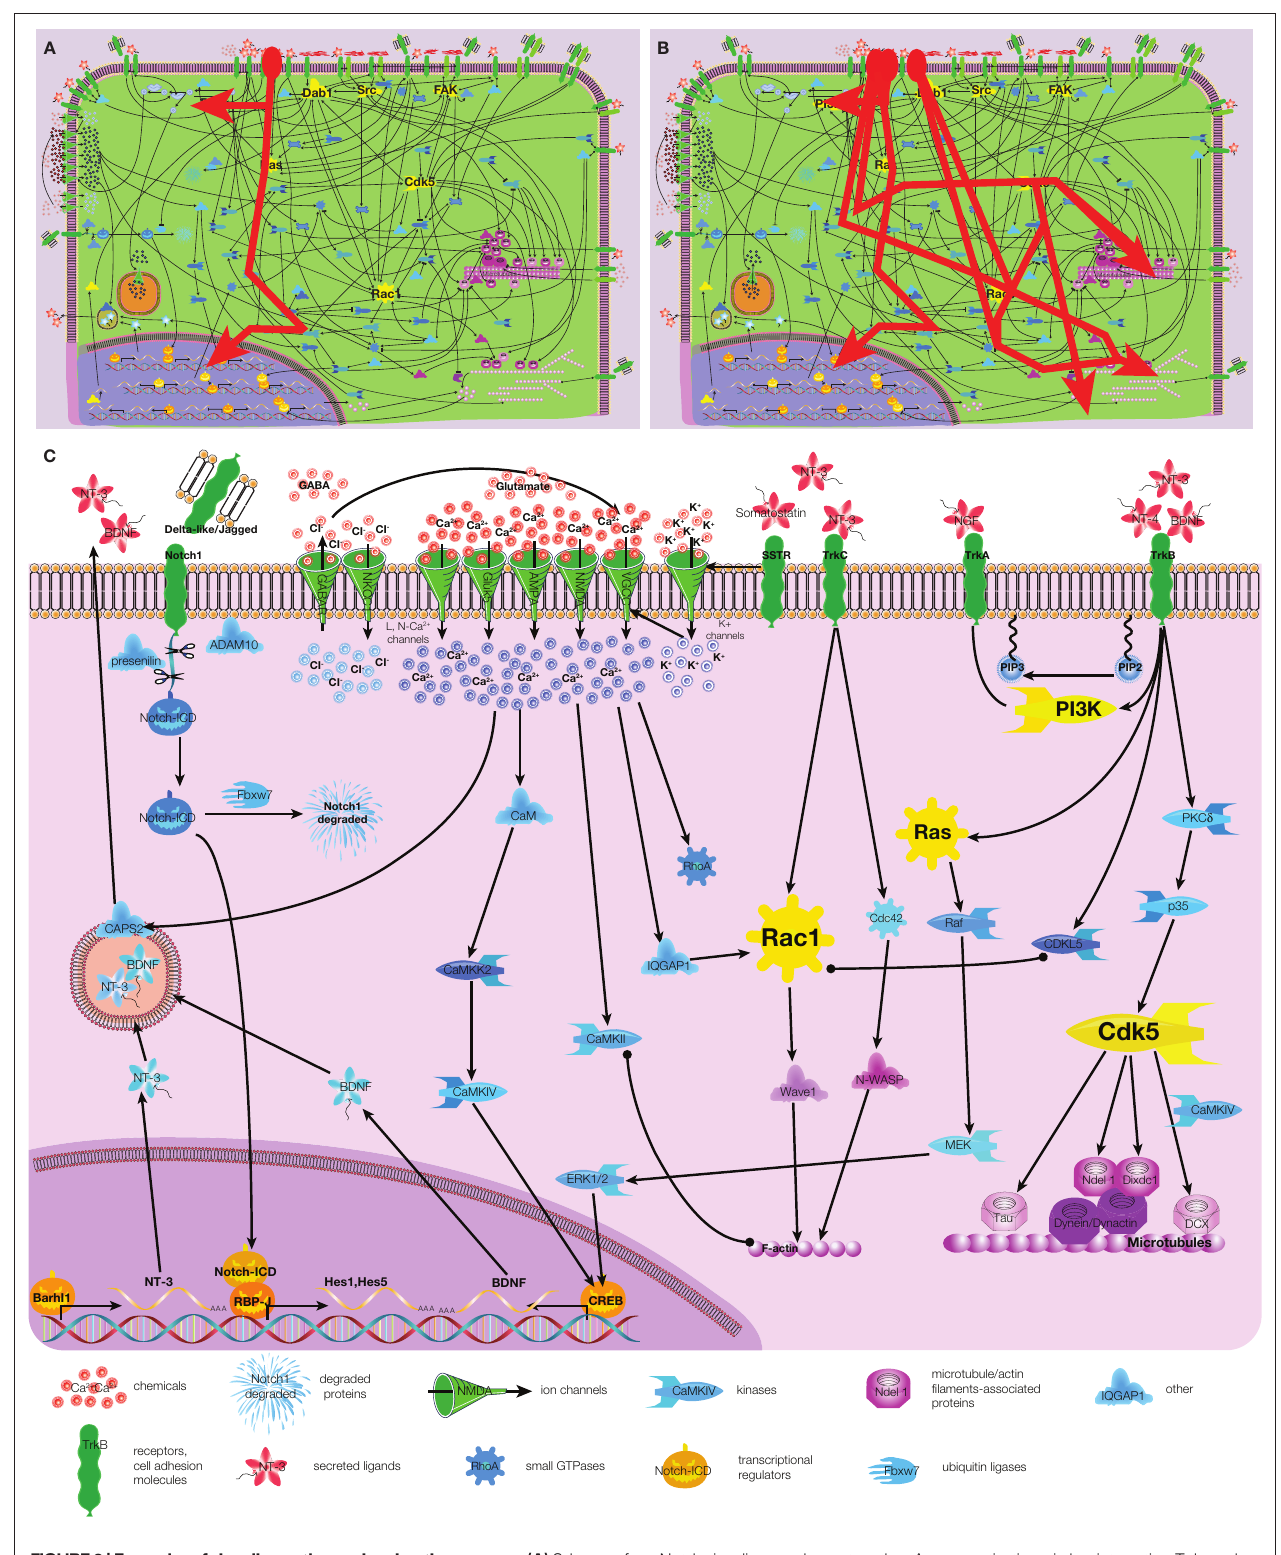
Figure 3 | examples of signaling pathways in migrating neurons. (A) Scheme of HGF signaling (highlighted by red). (B) Scheme of signaling for neurotrophin protein family (NT-3, NT-4, NGF, BDNF; highlighted in red). (C) Calcium, neurotrophin, and